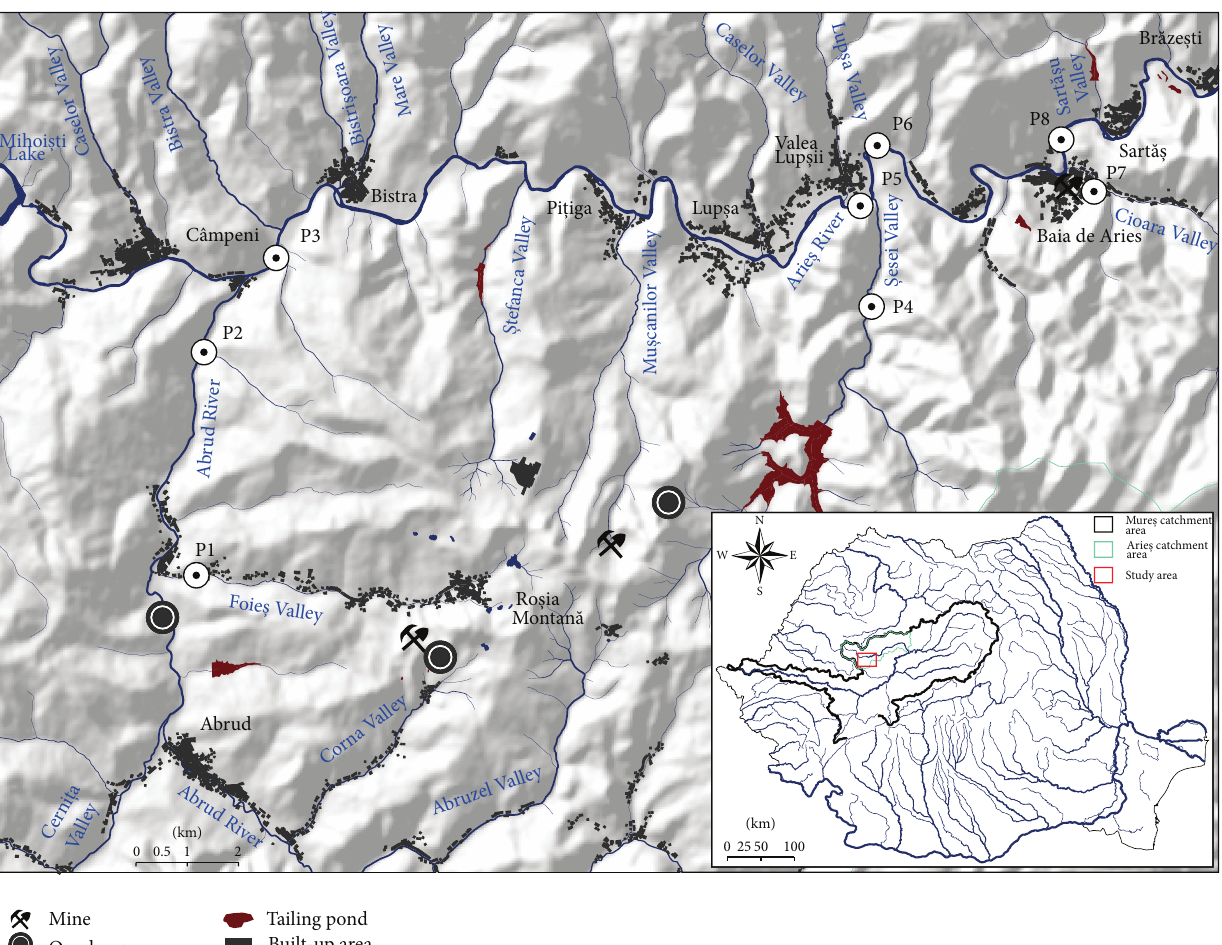
Figure 1: Aries River catchment, sampling stations, and mining